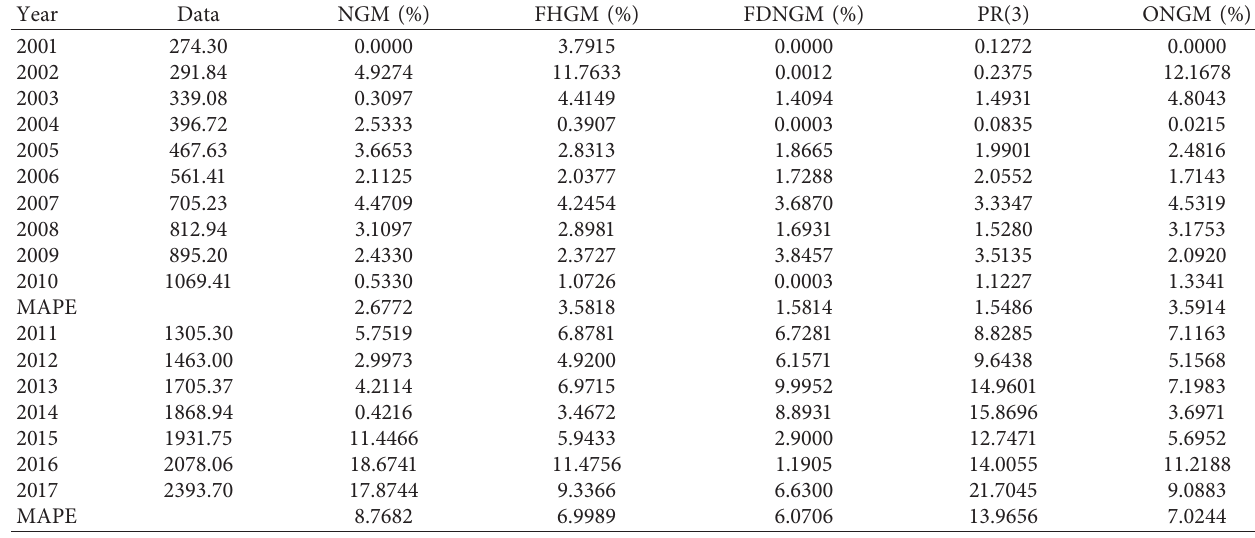
Table 4: The error-value indices of the competing models in Case 2.